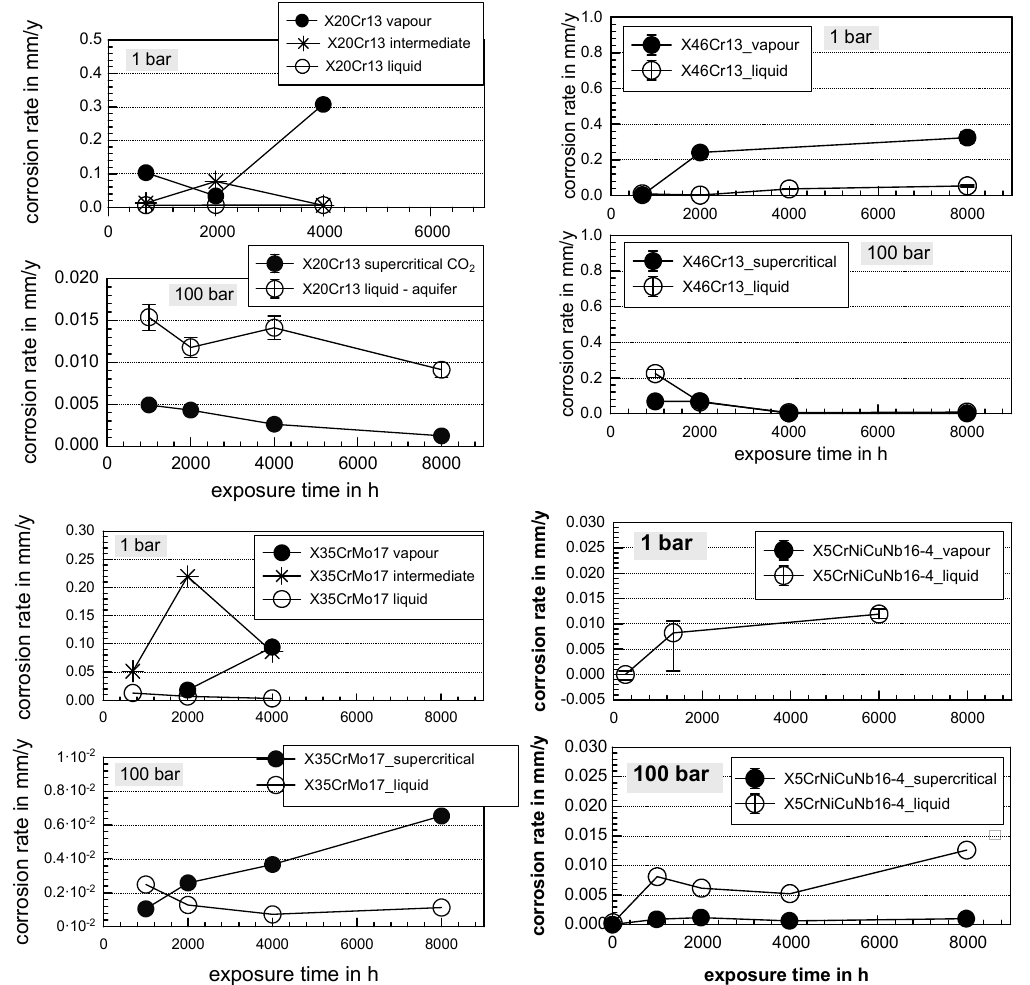
Figure 4. Comparison of corrosion rates in the liquid and vapor/supercritical phase after 8000 h of exposure to aquifer brine water at 60 °C and ambient pressure, as well as at 100 bar. ( Up left ): X20Cr13, ( up right ): X46Cr13 ambient pressure 100 bar, ( down left ): X35CrMo17-1, ( down right ): X5CrNiCuNb16-4.